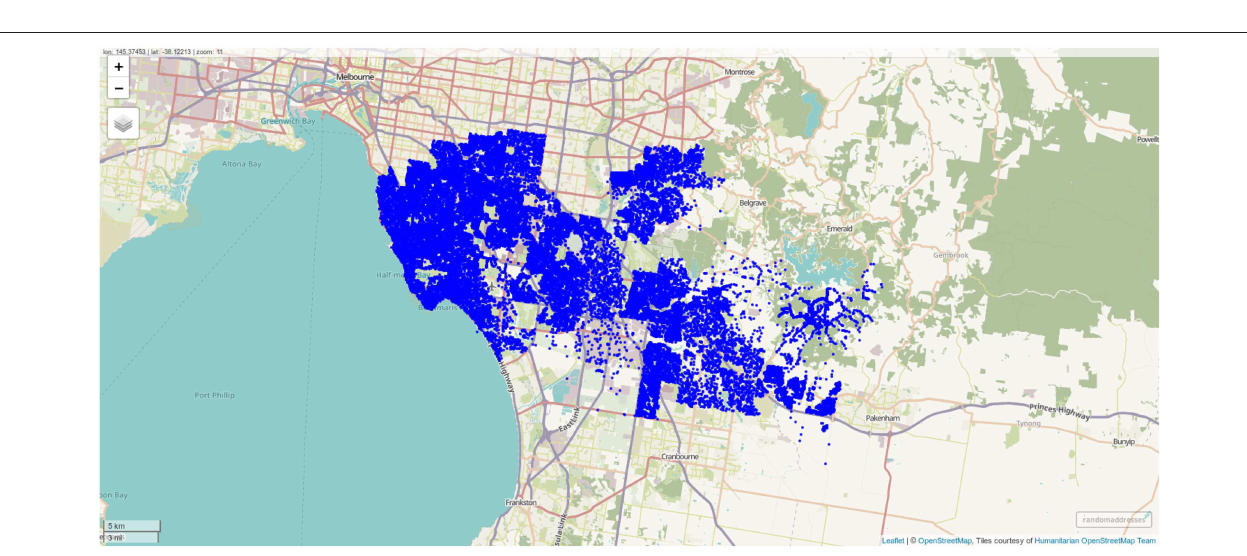
Frontiers in Neurology |